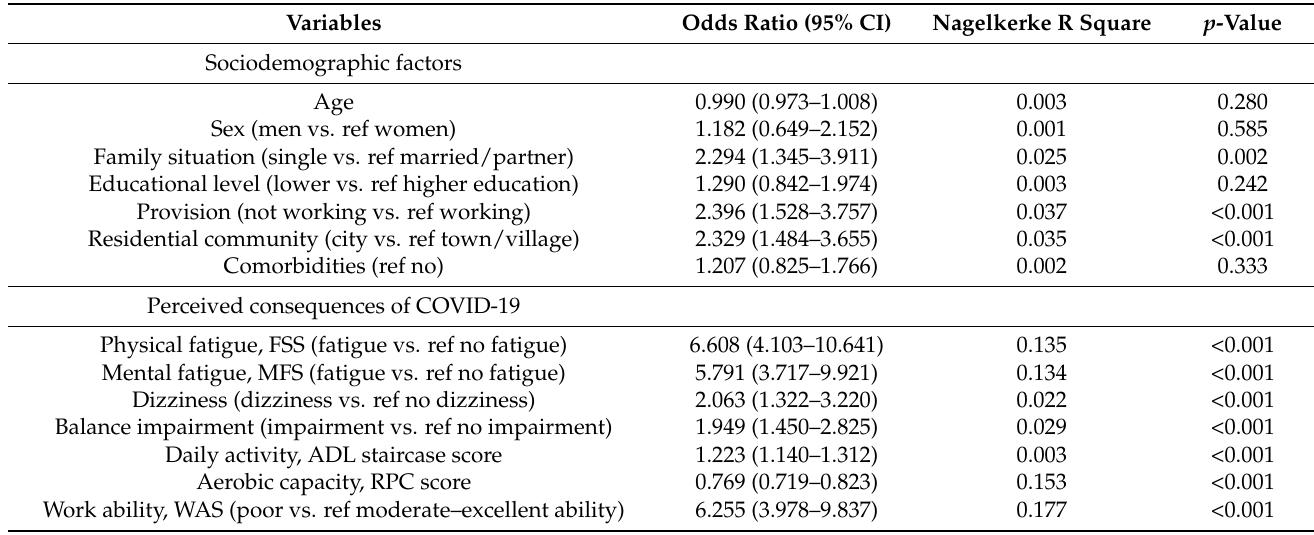
Table 4. Univariate logistic regression analyses of factors associated with low satisfaction with Life as a whole in persons with